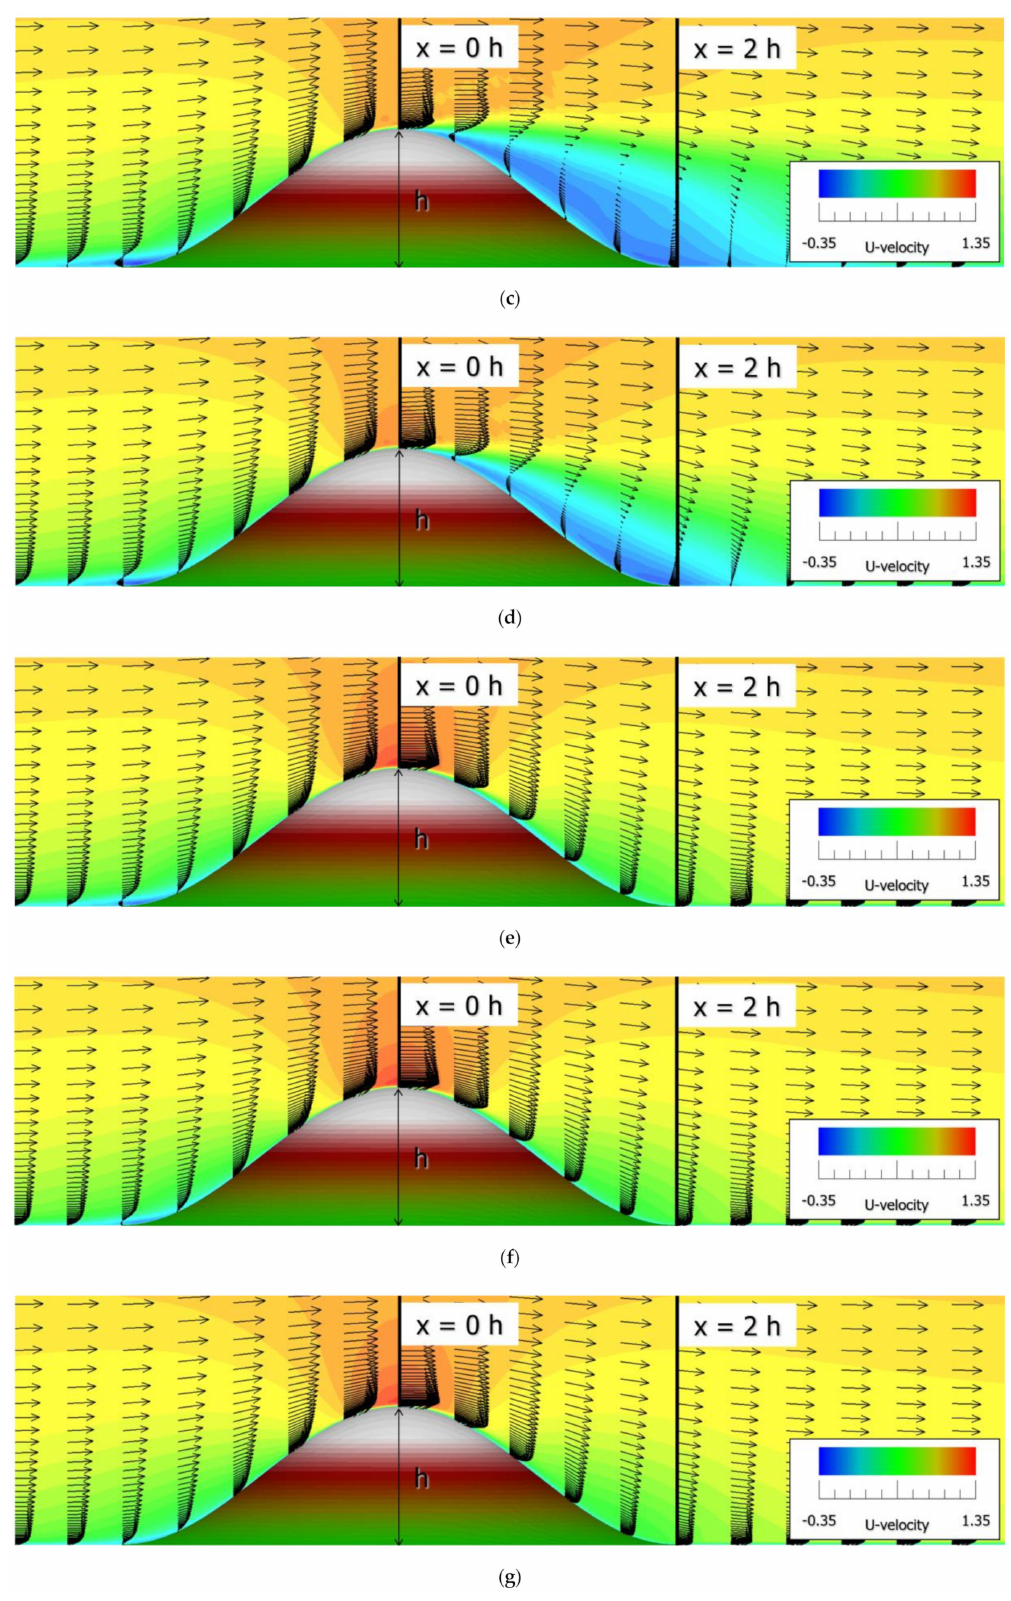
Figure 11. Comparison of time-averaged flow patterns near the hill under various stable conditions in the steep hill scenario. ( a ) Ri = 0.0 (neutral flow); ( b ) Ri = 0.2 (stable stratified flow); ( c ) Ri = 0.4 (stable stratified flow); ( d ) Ri = 0.5 (stable stratified flow); ( e ) Ri = 0.6 (stable stratified flow); ( f ) Ri = 0.8 (stable stratified flow); ( g ) Ri = 1.0 (stable stratified